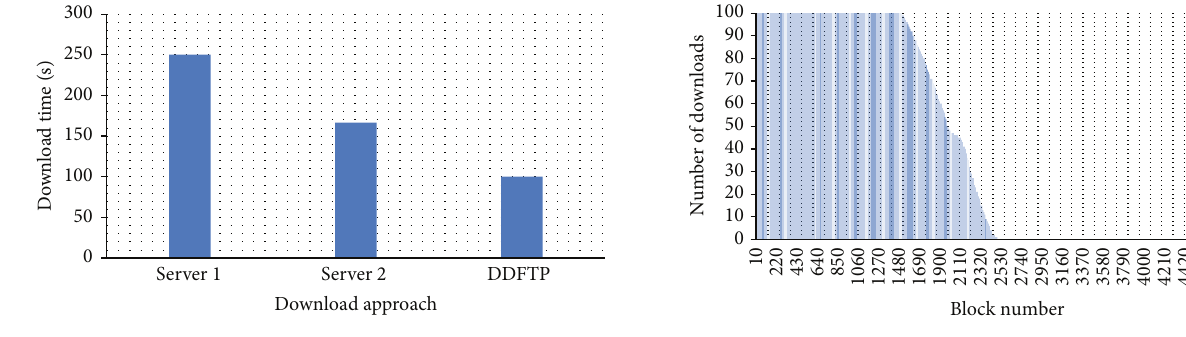
Figure 13: Effect of number of servers on blocks replication. Figure 14: Blocks download from Server